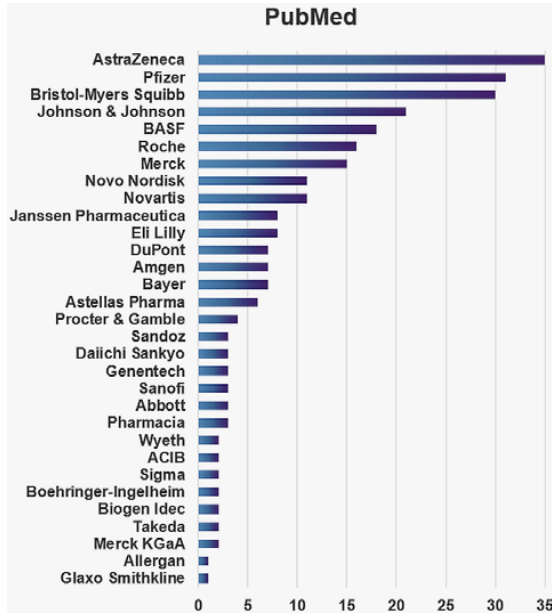
Figure 2. Metabolomics publication metrics from 1999 through 2015. The bar graph shows a number of publications that list key words ((metabolomics) OR metabonomics)) AND company name (Affiliation)) derived from the search in PubMed database.